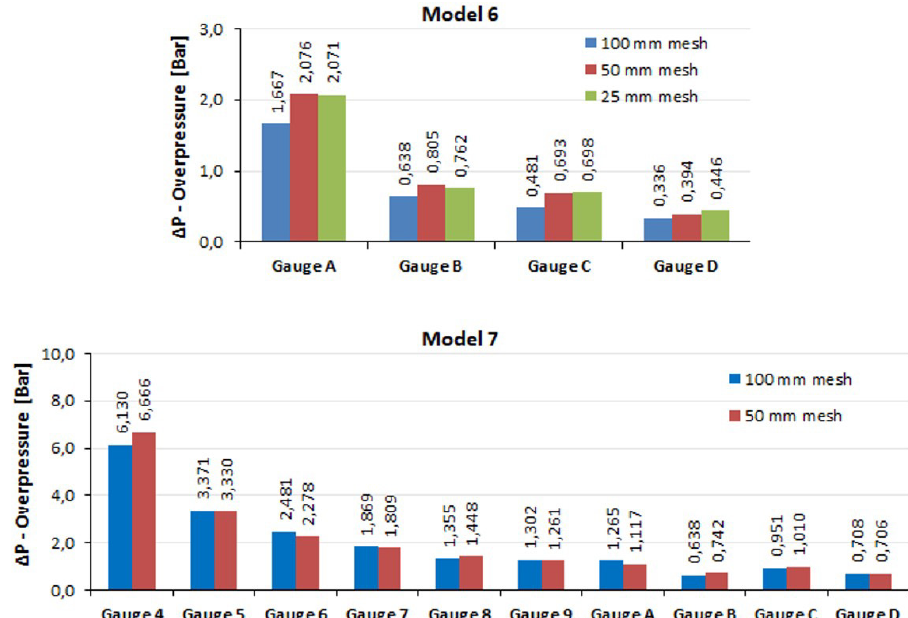
Figure 15. Overpressure peaks in the indicated gauges of models 6 and 7 (explosions from underground tanks with volumes of 8,0 m 3 and 120 m 3